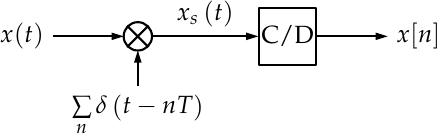
Figure 6. Block diagram of an ideal sampler. C/D is a continuous-to-discrete-time